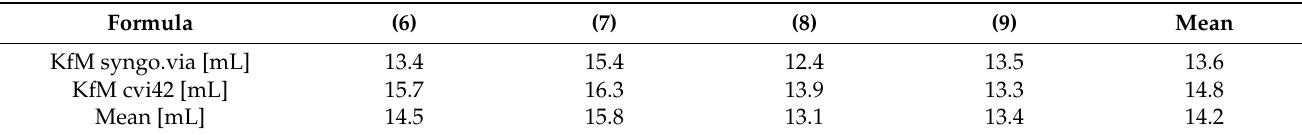
Table 2. Calculated, average papillary muscle